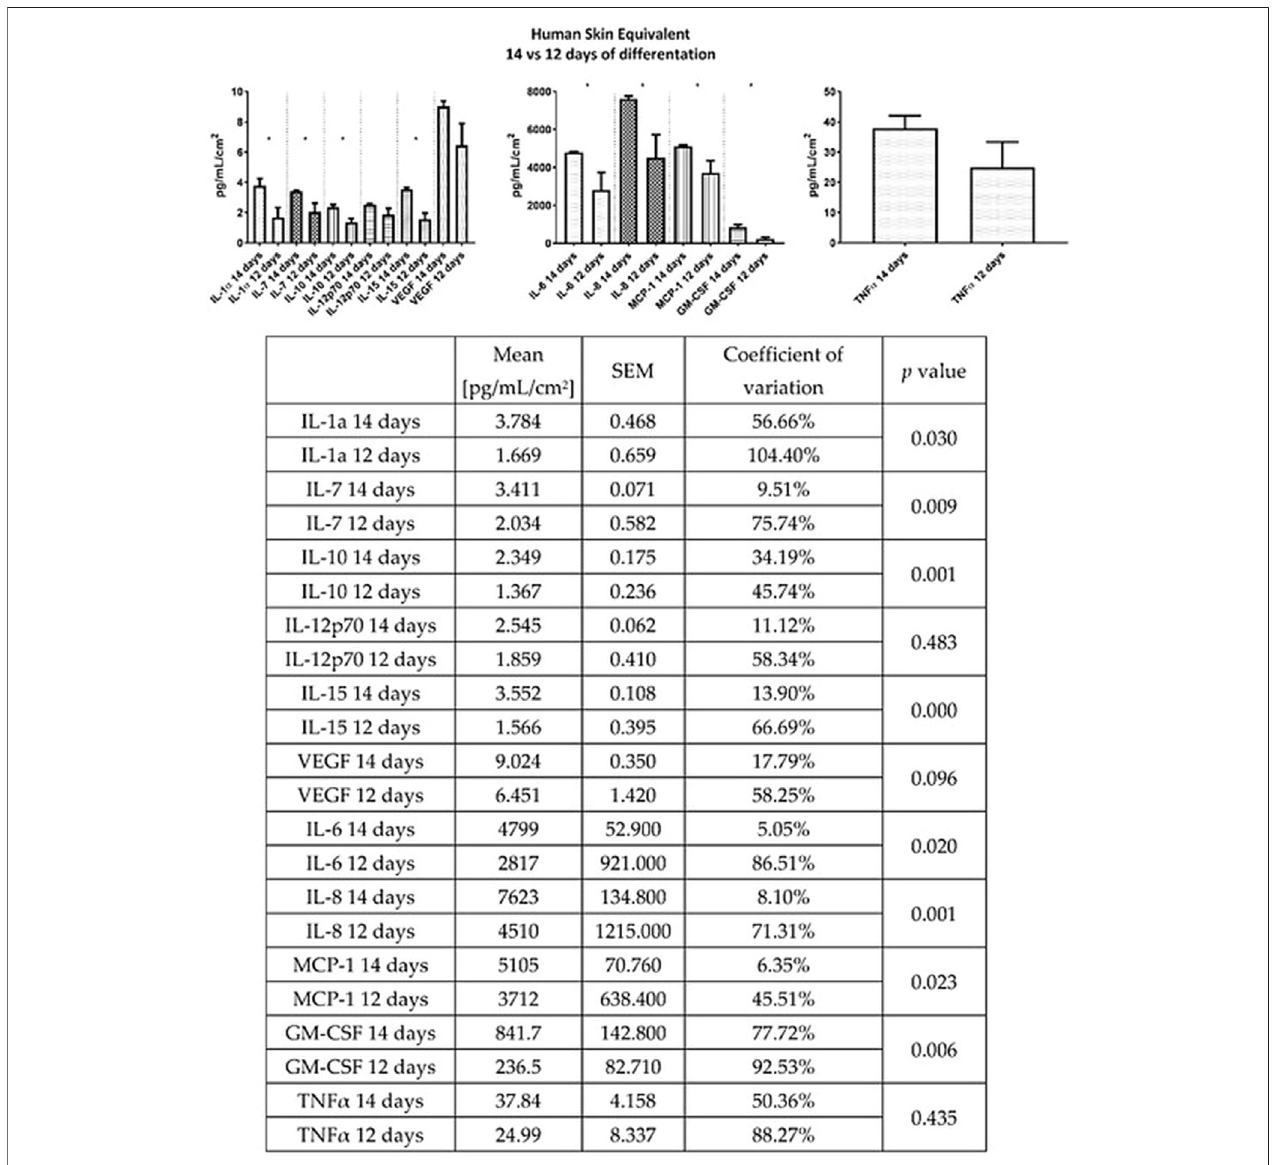
FIGURE 9 | GNP-crosslinked scaffolds as an alternative treatment for skin wounds. Antiin fl ammatory and antioxidant properties from GNP will accelerate the healing process.